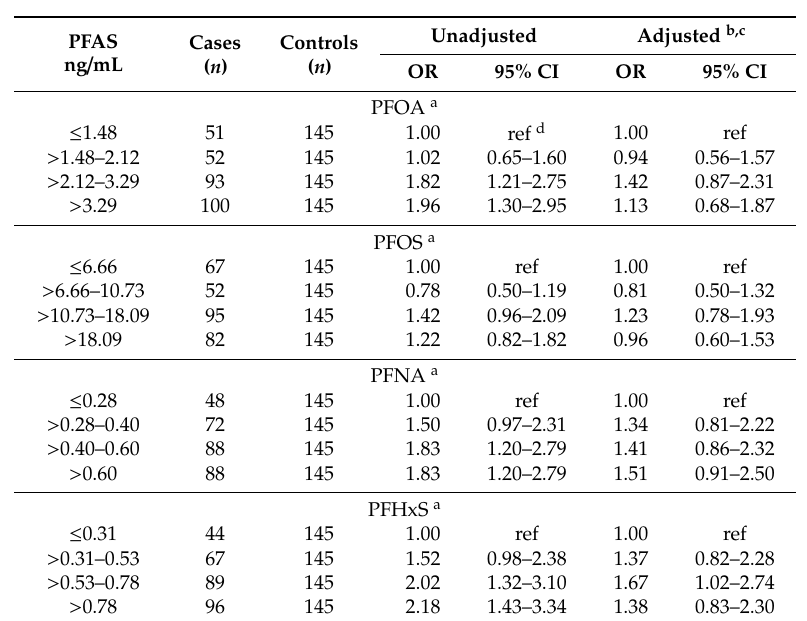
Table 4. The associations between concentrations of PFAS a in maternal serum in early pregnancy and preeclampsia (PE). Odds ratios (OR) and 95% confidence intervals (CI) were obtained from logistic